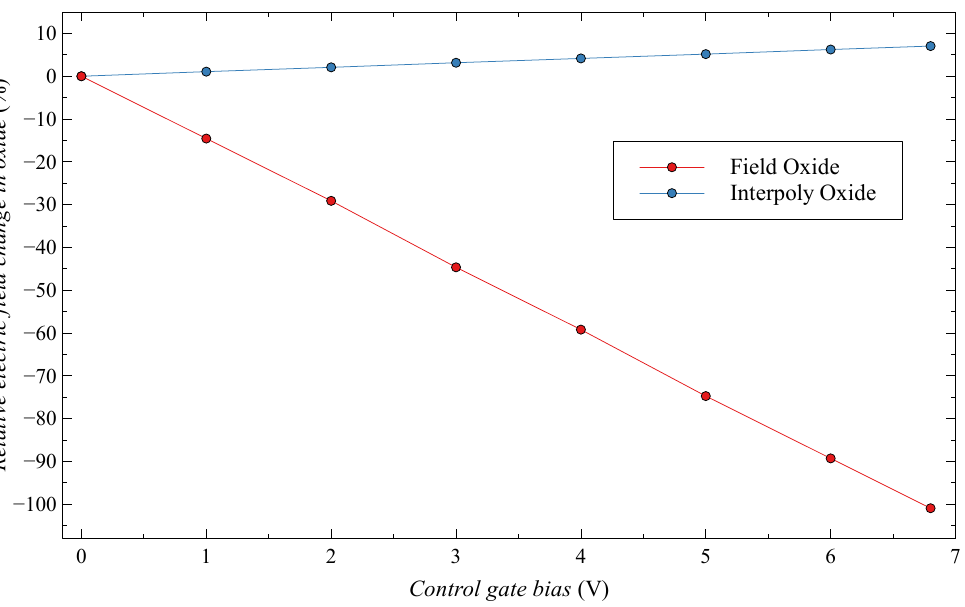
Figure 25. Electric field in field and interpoly